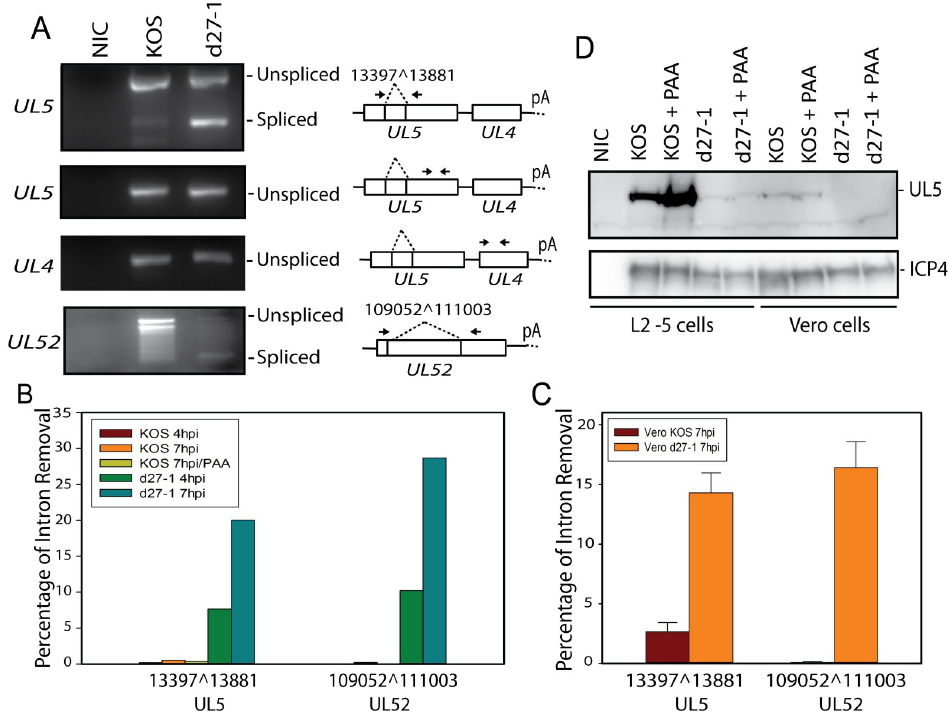
Fig 7. Replication associated early genes UL5 and UL52 are alternatively spliced genes and ICP27 inhibits the pre- mRNA splicing of these genes in a sequence specific manner. UL5 (primase/helicase) and UL52 (primase/helicase) were used as representative replication-associated genes. ( A ) cDNAs were prepared from HEK-293 cells infected with KOS or d27-1 at 7 hpi. RT-PCR using primers shown to right of each gel shows ICP27-dependent splicing of UL52 and UL5 but not UL4 transcripts. ( B ) Quantitative splicing efficiency analysis for UL5 and UL52 using the RNA-Seq data obtained from infected HEK-293 cells. ( C ) Quantitative splicing efficiency analysis for UL5 and UL52 using the RNA-Seq data obtained from infected Vero cells at 7 hpi (performed in triplicate). ( D ) Western blot showing that the ICP27 deletion in viral mutant d27-1 significantly reduces protein expression of UL5